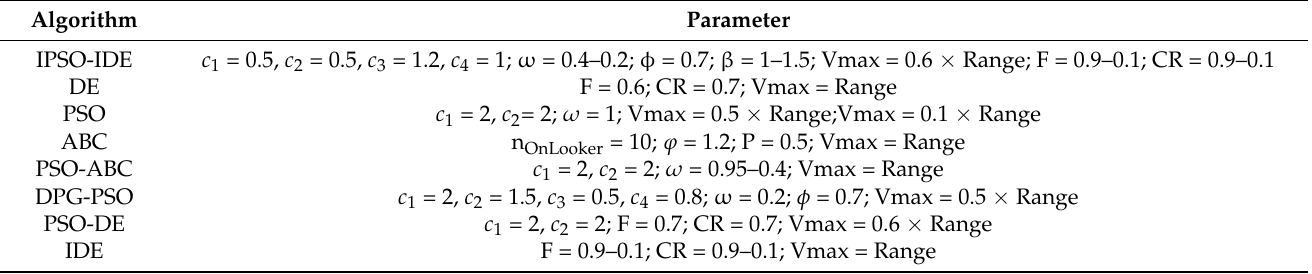
Table 4. Parameter settings of the different test algorithms (meaning of the symbols are provided in the respective literatures.